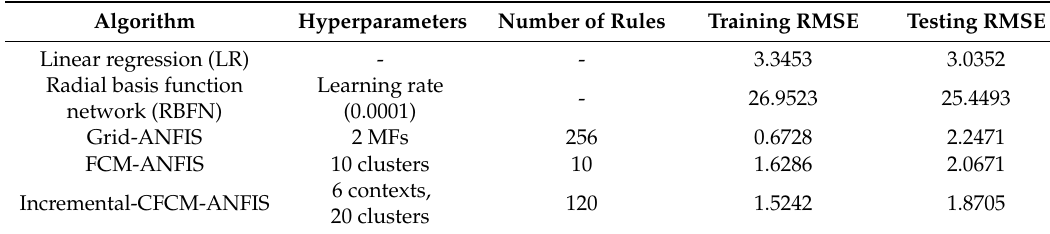
Figure 8. Comparison of ANFIS predicted values with actual output values in an incremental tree structure based on CFCM clustering. Table 4. Analysis of experimental results from ANFIS based on grid-based ANFIS, FCM-clustering-based ANFIS and the CFCM-clustering-based incremental tree